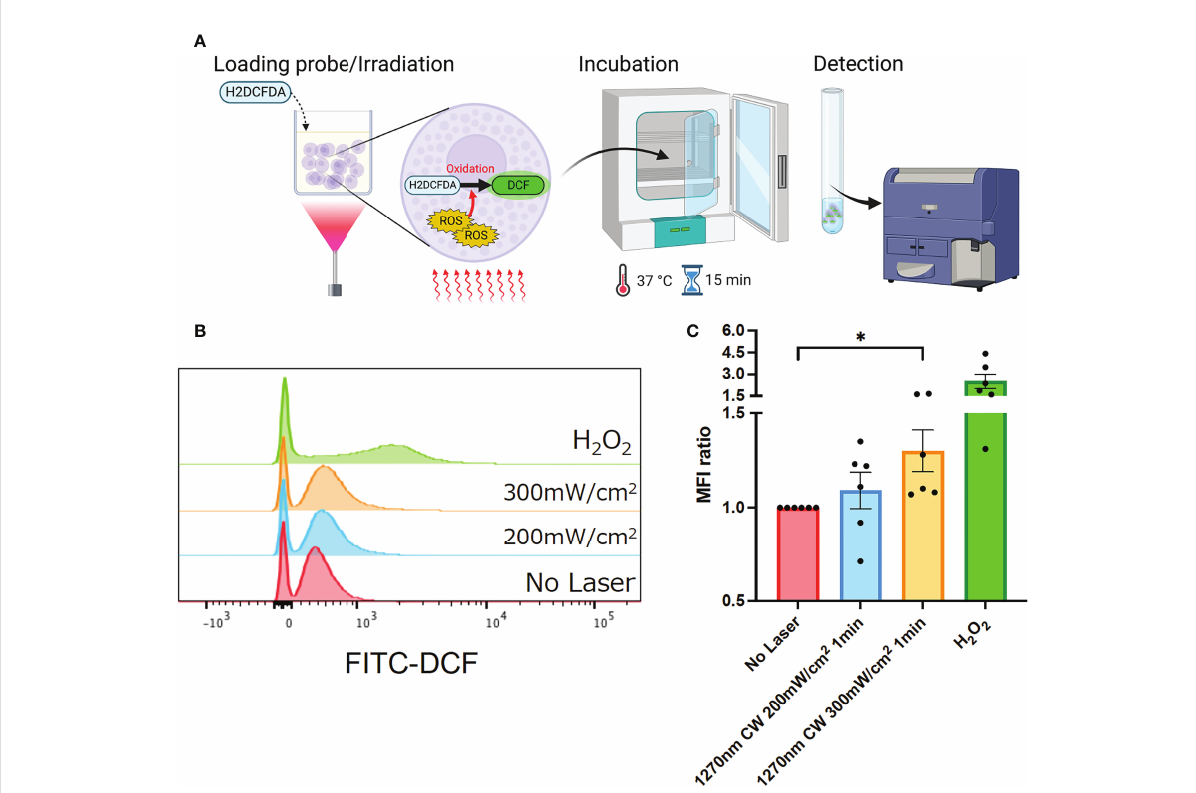
FIGURE 2 Generation of reactive oxygen species (ROS) induced by the near-infrared (NIR) laser treatment of cultured mast cells. (A) Release of ROS by the NIR laser treatment was assesssed by ROS-sensitive fl uorescence probe, H 2 DCFDA, in P-815 in vitro . (B) P-815 cells were treated with the NIR laser at a power of 200 or 300 mW/cm 2 for 1 min. ROS-reacted DCF-dependent fl uorescence was measured using fl ow cytometry. (C) Fold increase in DCF+ population compared with that in no-laser control was calculated for each condition. Kruskal – Wallis test with Dunn ’ s multiple comparisons test (No Laser vs. 200 mW/cm 2 , 300 mW/cm 2 , * p <0.05. n = 6 per group), Error bars show mean ±